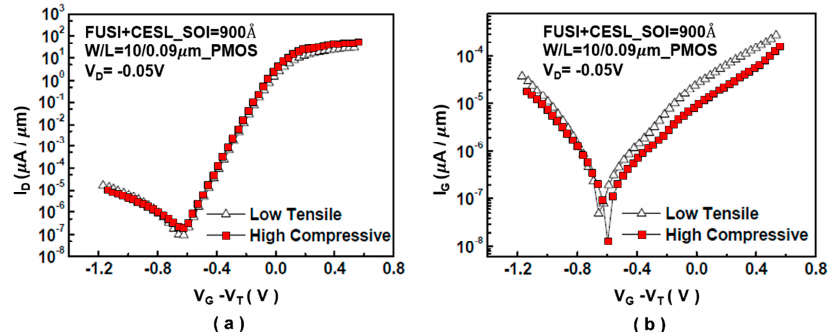
Figure 15. Comparison of I D and I G in PMOS non-conducting elements subjected to different layer strains: ( a ) I D – V G diagram and ( b ) I G – V G diagram [12].